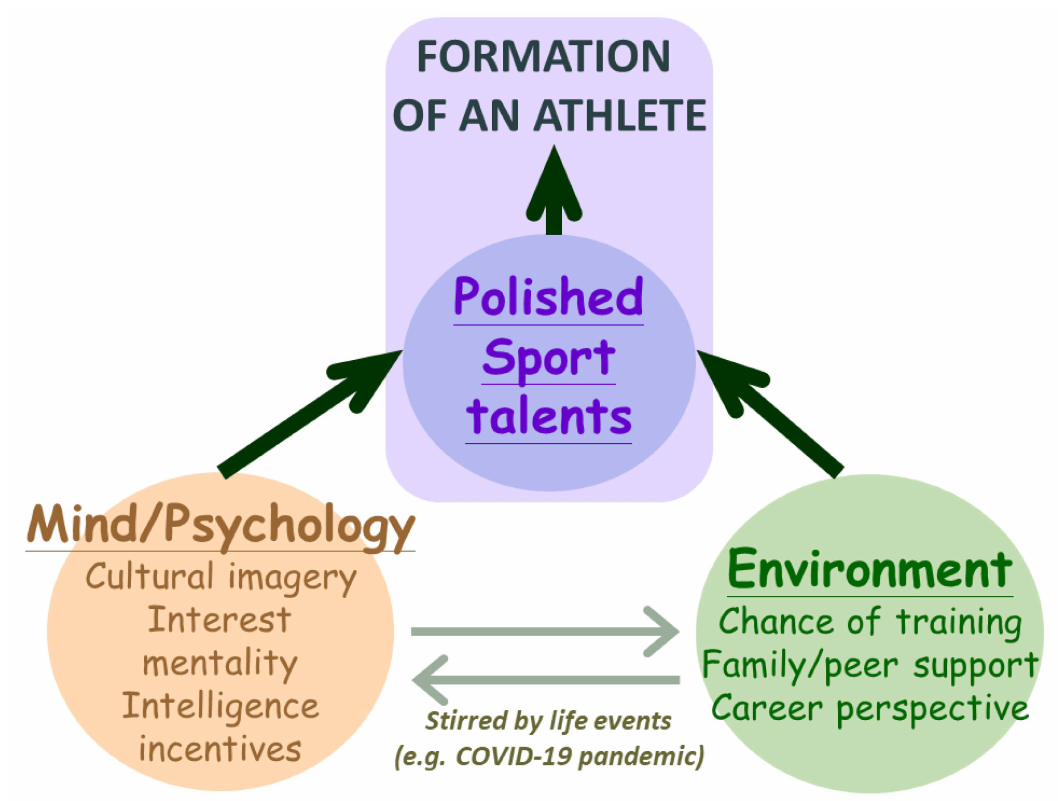
Figure 1. The most important attribute for the formation of an athlete is one’s polished sports talent, which is supported or discouraged by environmental and psychological factors. One’s environment and mentality can be influenced dynamically by life or world events, such as the COVID-19